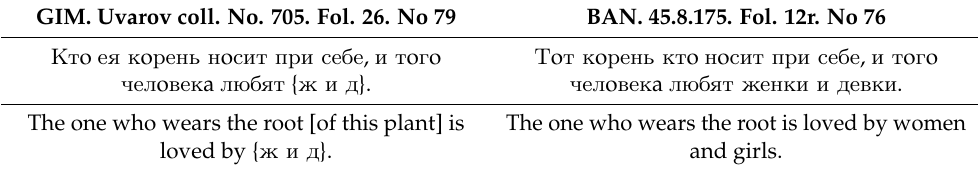
Table 3. Texts about the Peresyanka plant .